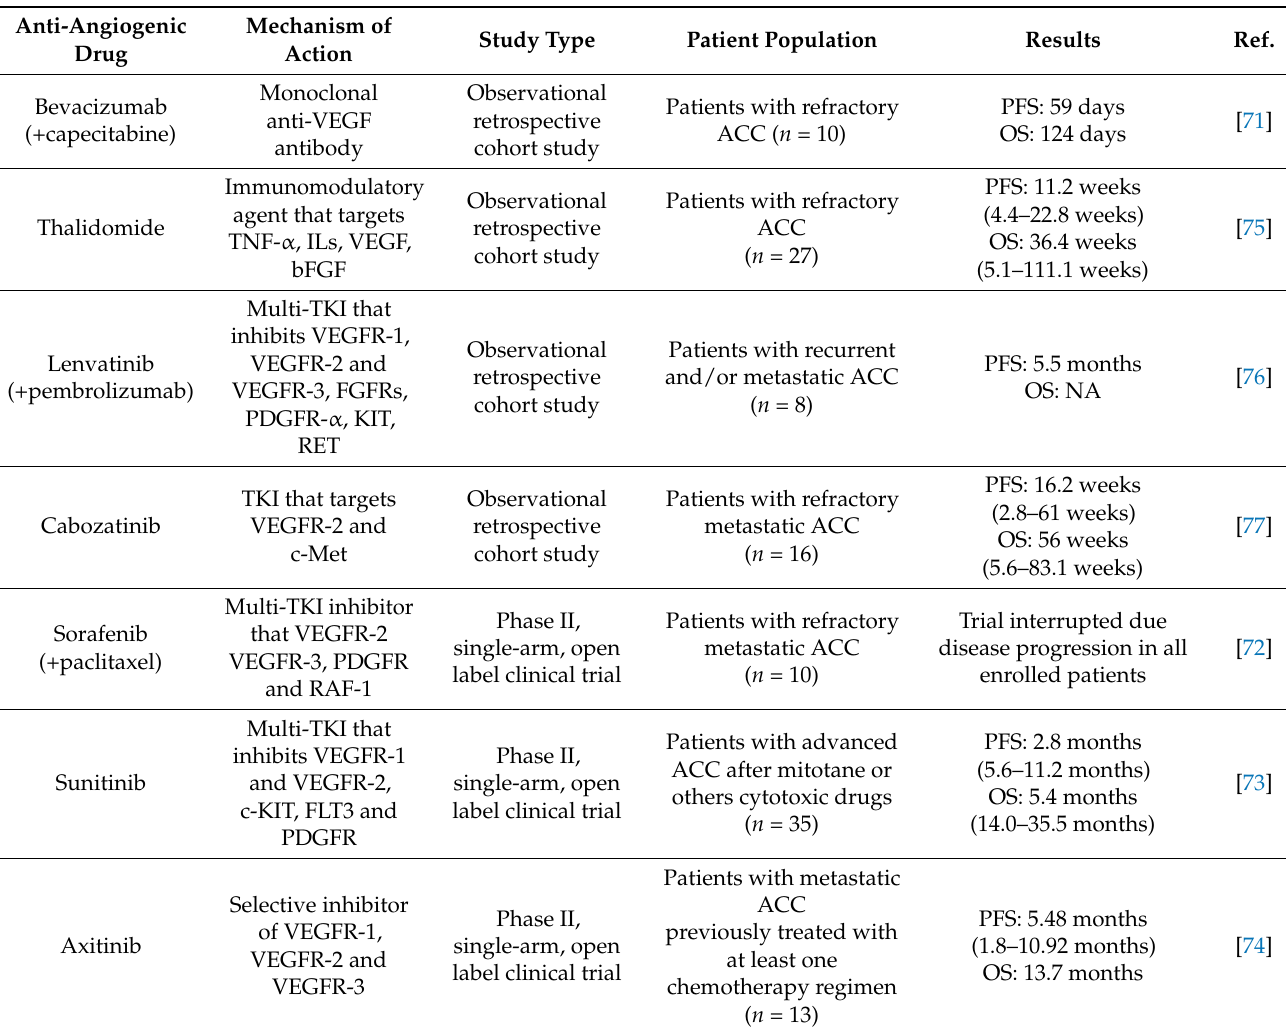
Table 2. Clinical studies using anti-angiogenic drugs for the treatment of patients with adrenocortical carcinomas. Anti-Angiogenic